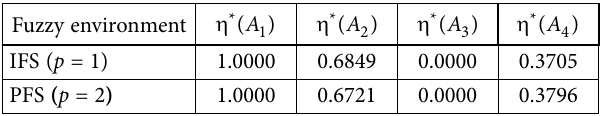
Table 13. Overall dominance with IFS/PFS Fuzzy